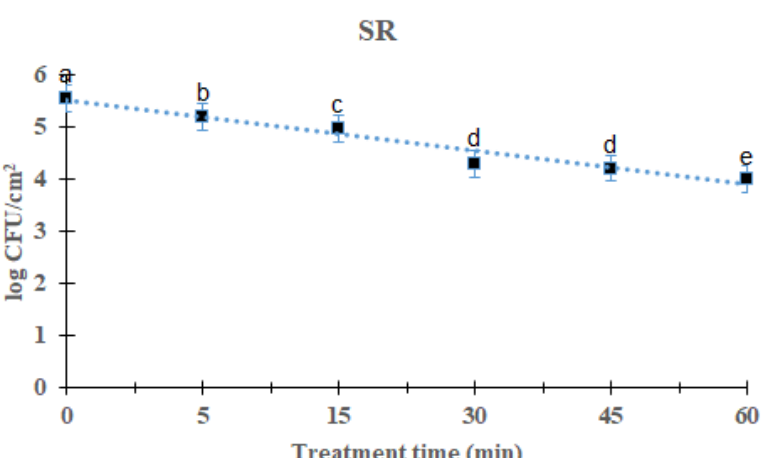
Figure 3. Survival curves of Listeria monocytogenes biofilm in silicon rubber treated by DBD plasma using the first-order kinetic model. The data were represented by the mean ± standard deviation of the three independent replicates. a–e Values marked with different letters within each treatment are significantly different by Duncan’s multiple range test ( p <